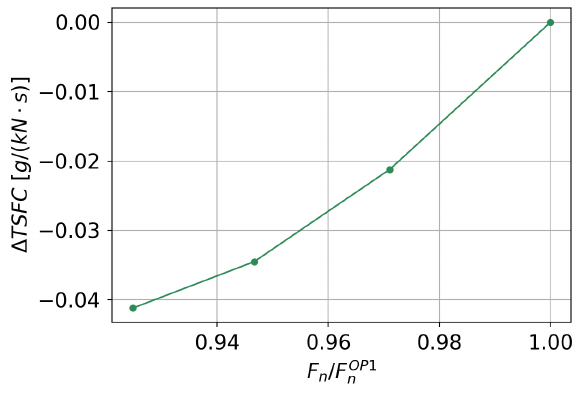
Figure 11. Relation between net force and TSFC change along the cruise